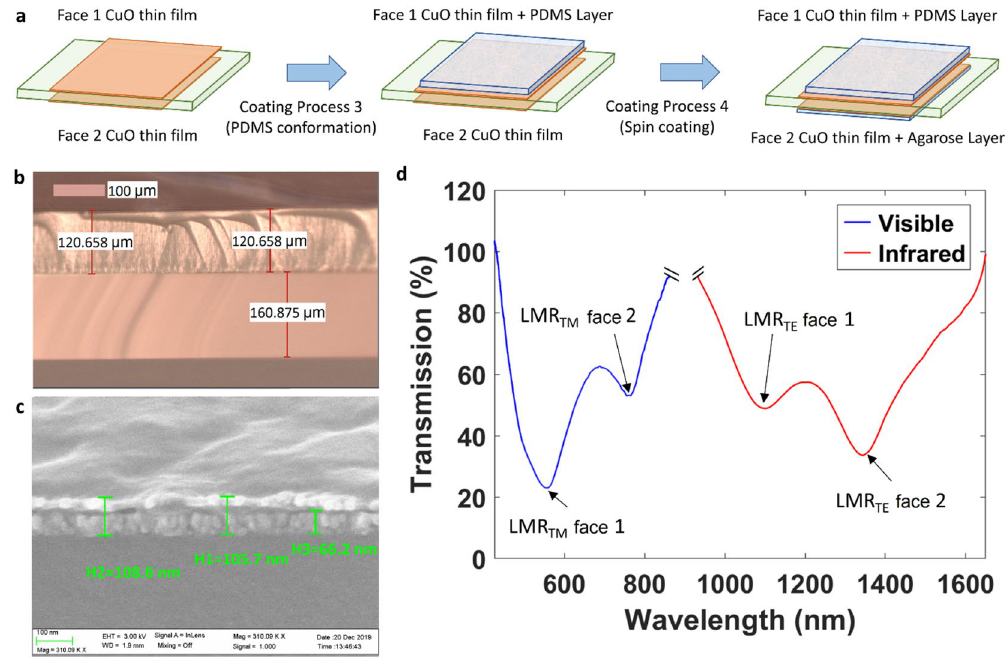
Figure 3. Deposition and characterization of agarose and PDMS coatings. ( a ) The upper face (face 1) and the lower face (face 2) of the coverslip are respectively deposited with agarose and PDMS. ( b ) Inverted microscope image showing the thickness of the PDMS coating, around 120 μm, deposited on a coverslip of thickness around 160 μm. ( c ) SEM microscope image showing the thickness of the agarose coating deposited on face 2 of the coverslip. The agarose layer can be distinguished on top of the CuO layer. The overall thickness of both layers is around 100 nm. ( d ) Optical spectra in the visible and NIR ranges after deposition of agarose and PDMS. Four LMRs are observed: two in the visible region, both of them TMs, and two in the NIR region, both of them